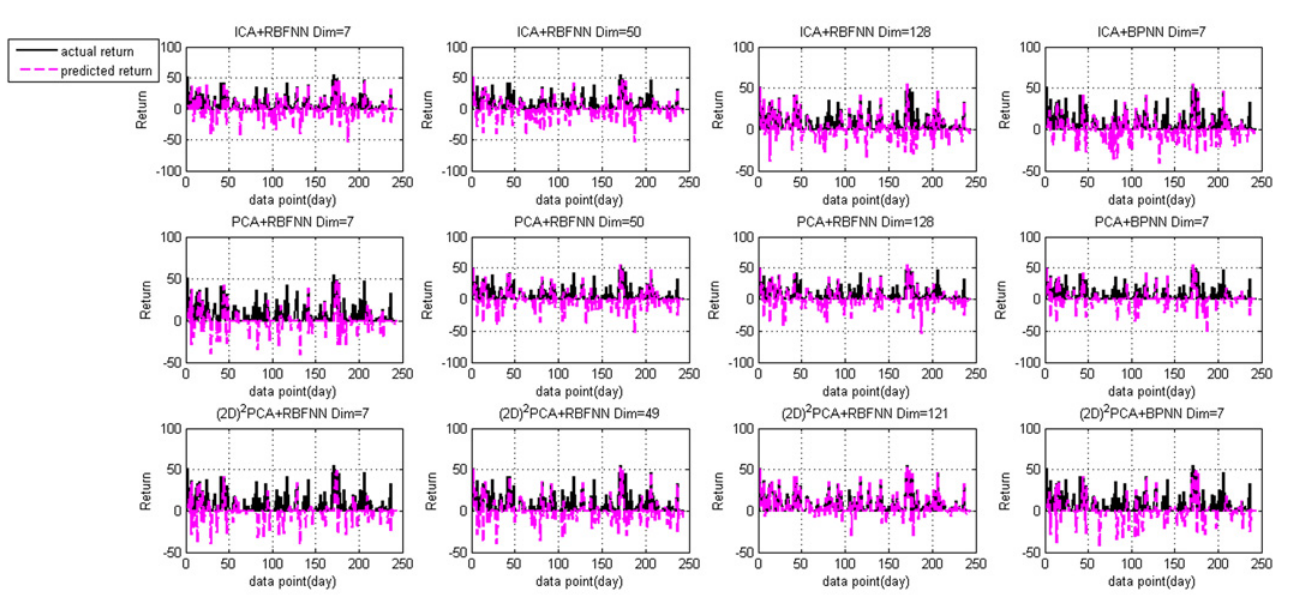
Fig 6. Curve of return time series. The red and black colored curves indicate the prediction return and actual return, respectively. The top, middle and bottom row display the returns of ICA, PCA and (2D) 2 PCA associated with RBFNN (Dim = 7,50,128) and BPNN (Dim = 7), respectively.